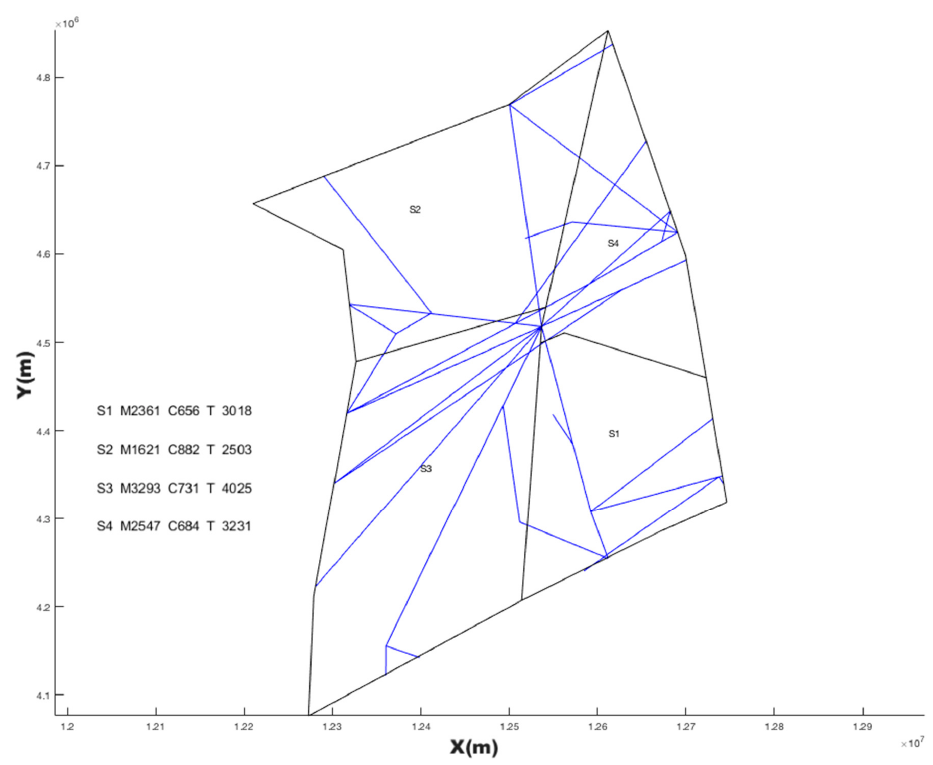
Figure 17. Current configuration and task load.